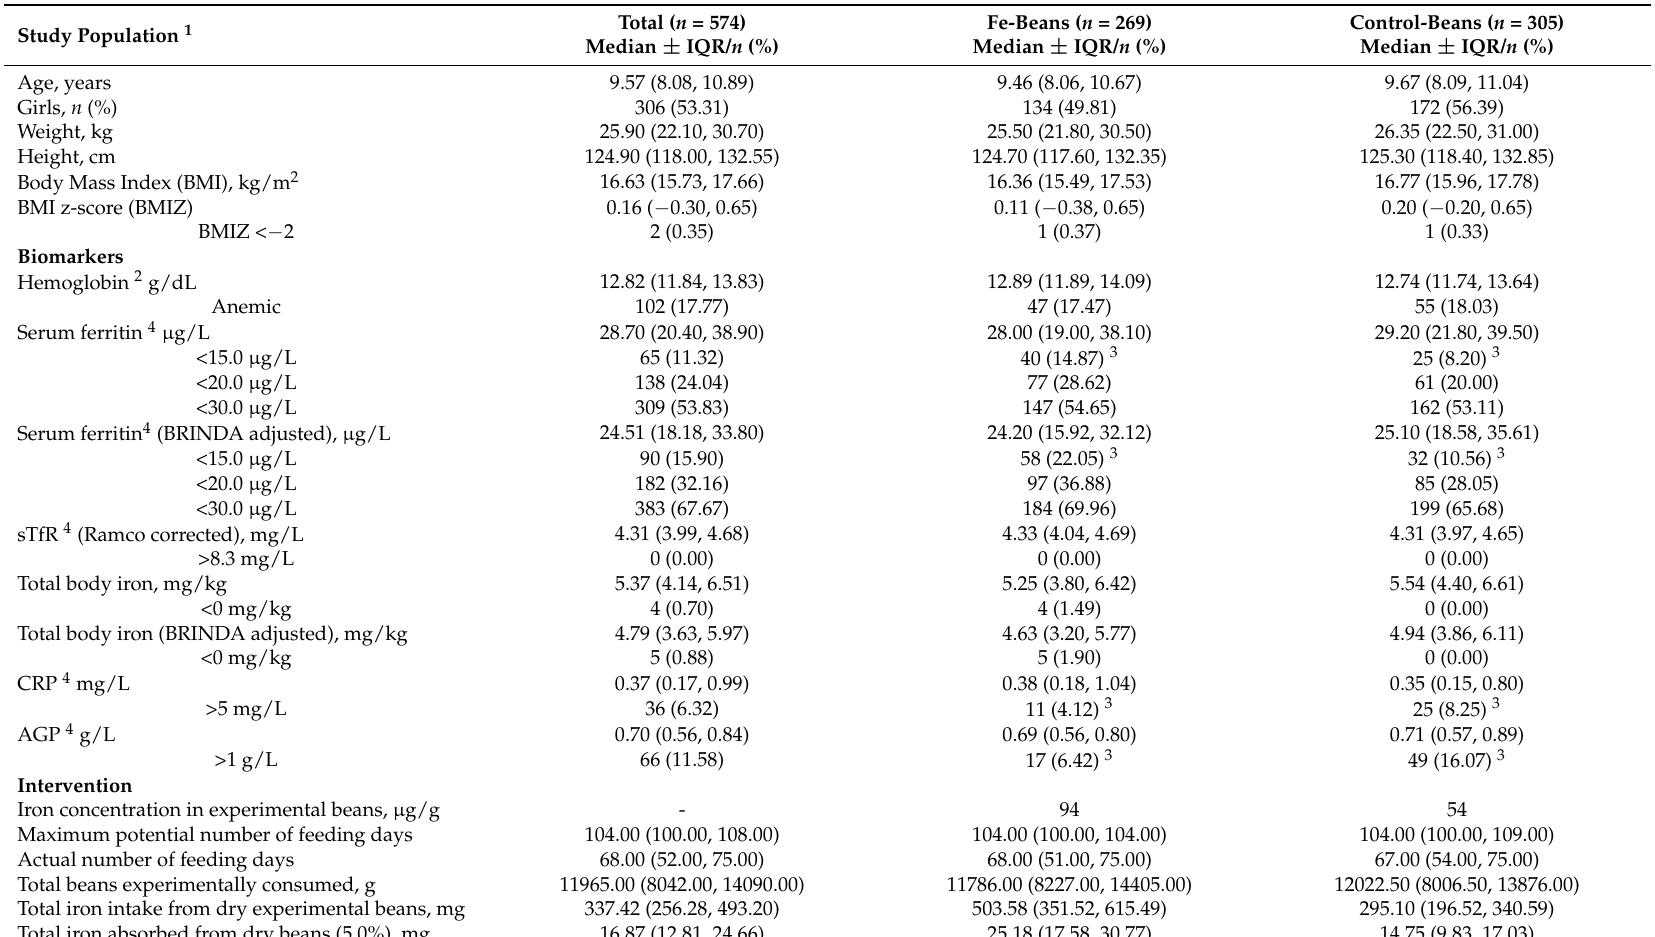
Table 1. Baseline characteristics of the study population and